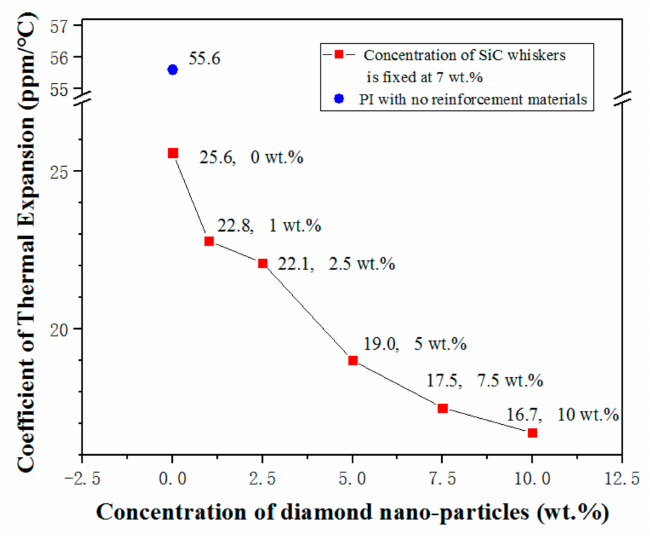
Figure 7. Coe ffi cient of thermal expansion (CTE) of the composite versus di ff erent DN concentrations.